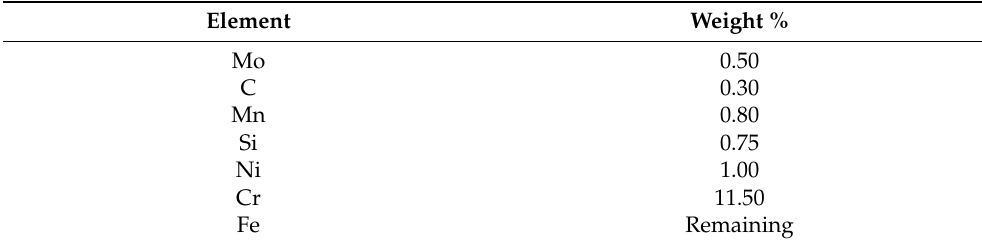
Table 5. Chemical composition of AISI 1030 steel [7].